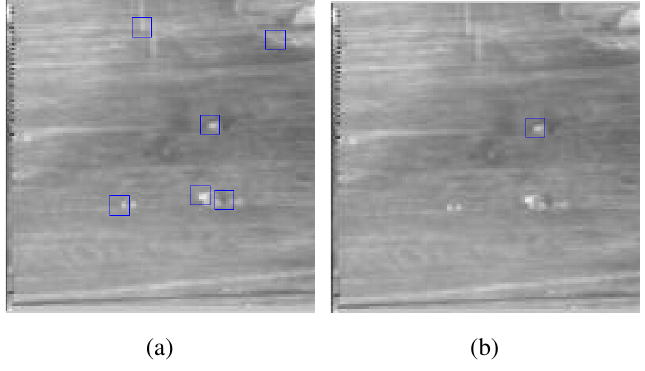
Figure 7. The contrast of one layer method and two layers method. ( a ) Result of one layer method. ( b ) Result of two layers method.